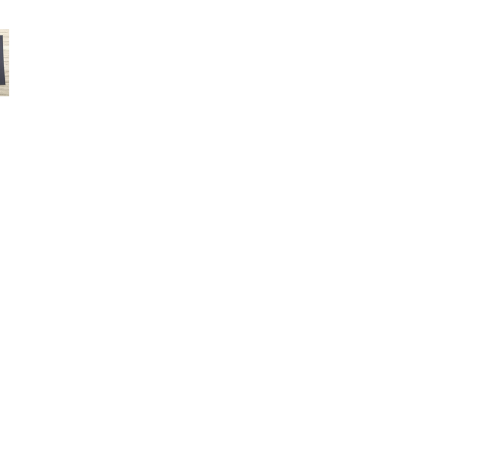
Figure 5. Comparison of simulated S parameters of the traditional CSSPP waveguide (blue line with squires and black line) and the proposed design (orange line with dots and red dashed line) with grooves’ depth of 5 mm.